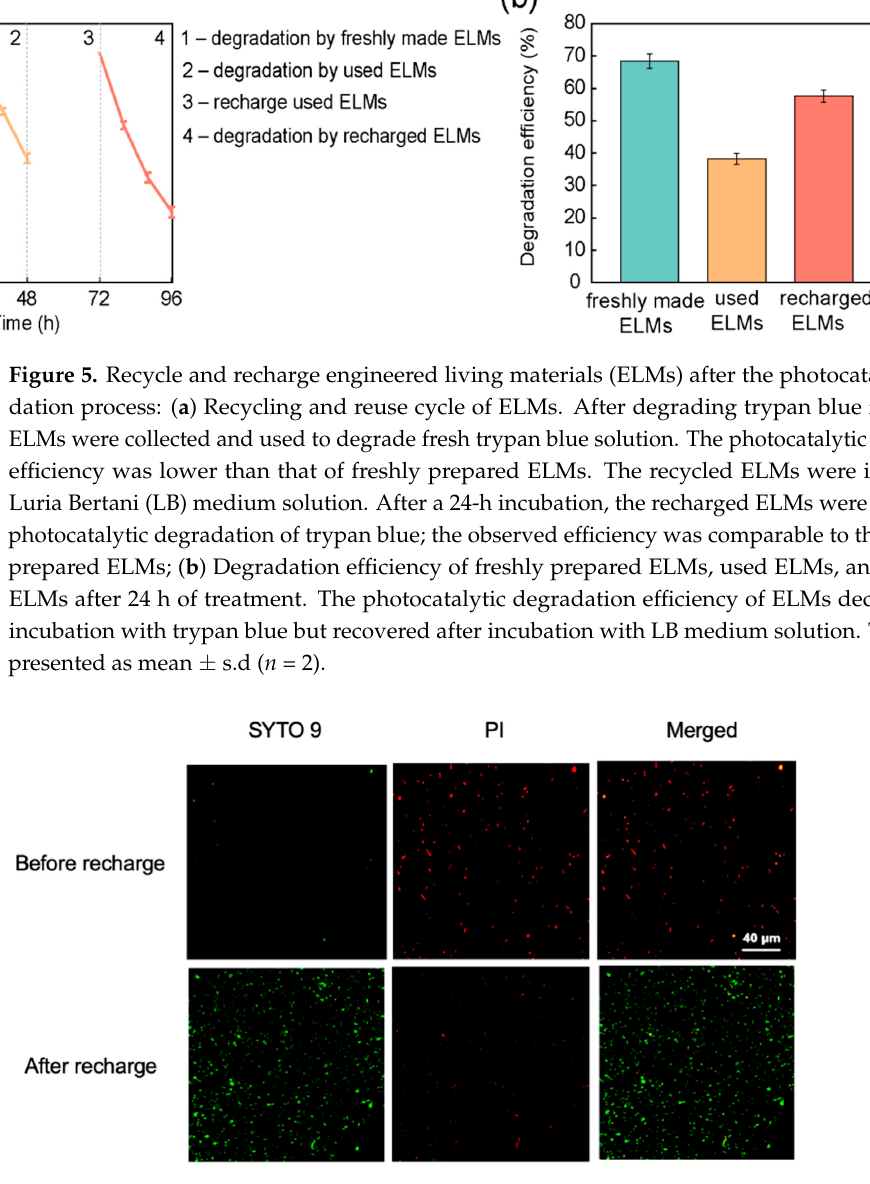
Figure 6. Cell viability in recharged engineered living materials (ELMs). After photocatalytic degradation of trypan blue, spheres were incubated in a culture medium solution. The recharged ELMs spheres were washed with PBS solution and dissolved using EDTA solution. The released cells were co-stained with SYTO 9 and PI and subsequently analyzed under a confocal laser scanning microscope. The majority of the hybrid cells in the recharged ELMs were alive.